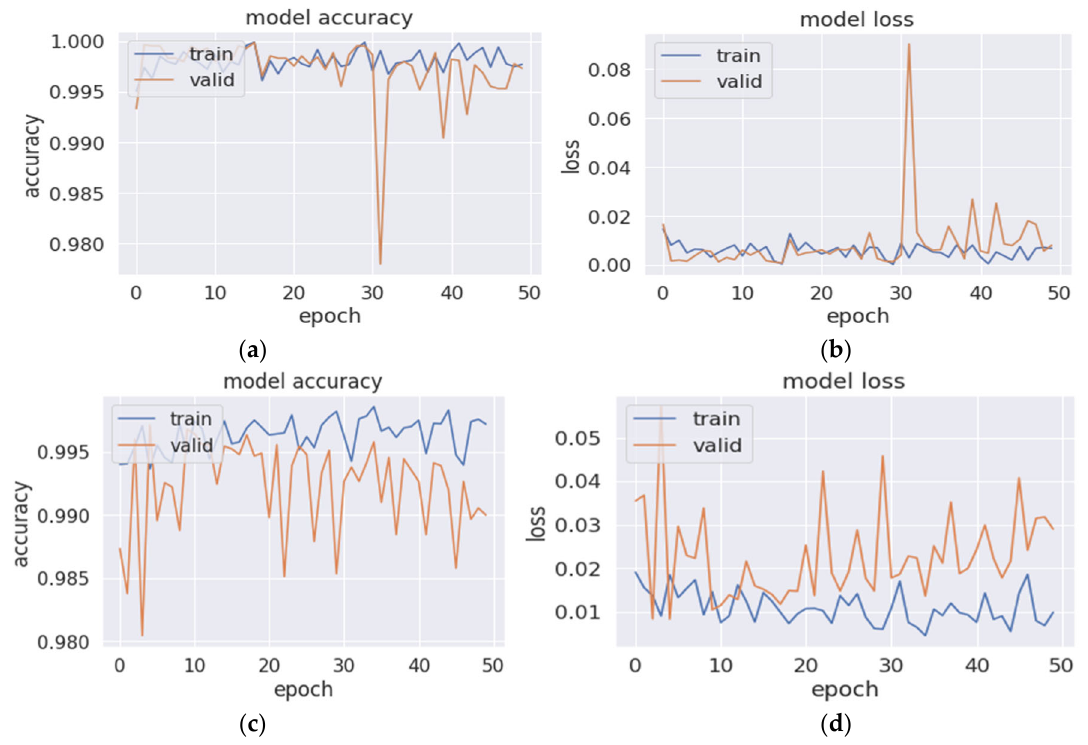
Figure 7. The accuracy and loss curves of the proposed model during the data training and valida- tion ( a , b ) for the best-performing model with three scales and kernel sizes of 5, 7, and 9 and ( c , d ) for the model with four scales of 5, 7, 9, and 11.